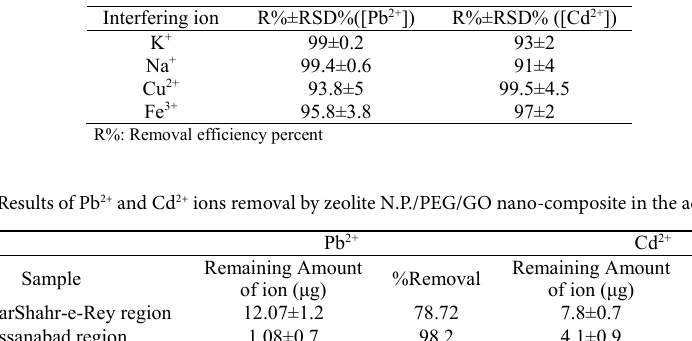
Table 4. Comparison of adsorption capacity (qe) and removal experimental parameters for Pb(II) and Cd(II) ions